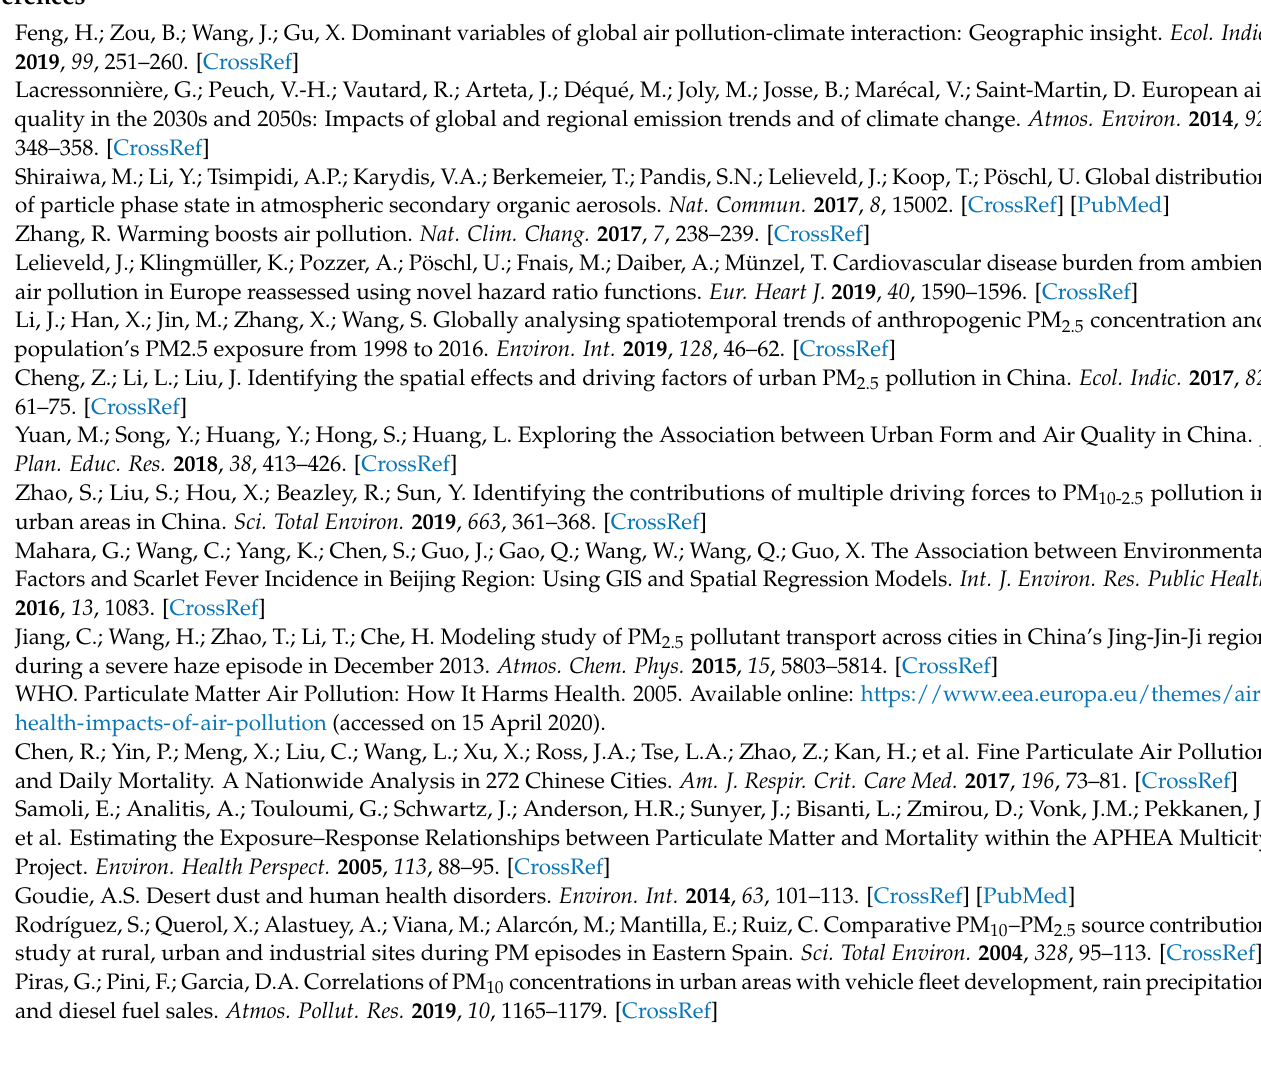
Table S1: Regression results of PM 2.5 , PM 10 , and PM 2.5 /PM1 0 based on OLS; Table S2: Summary of the characteristics of variables in each